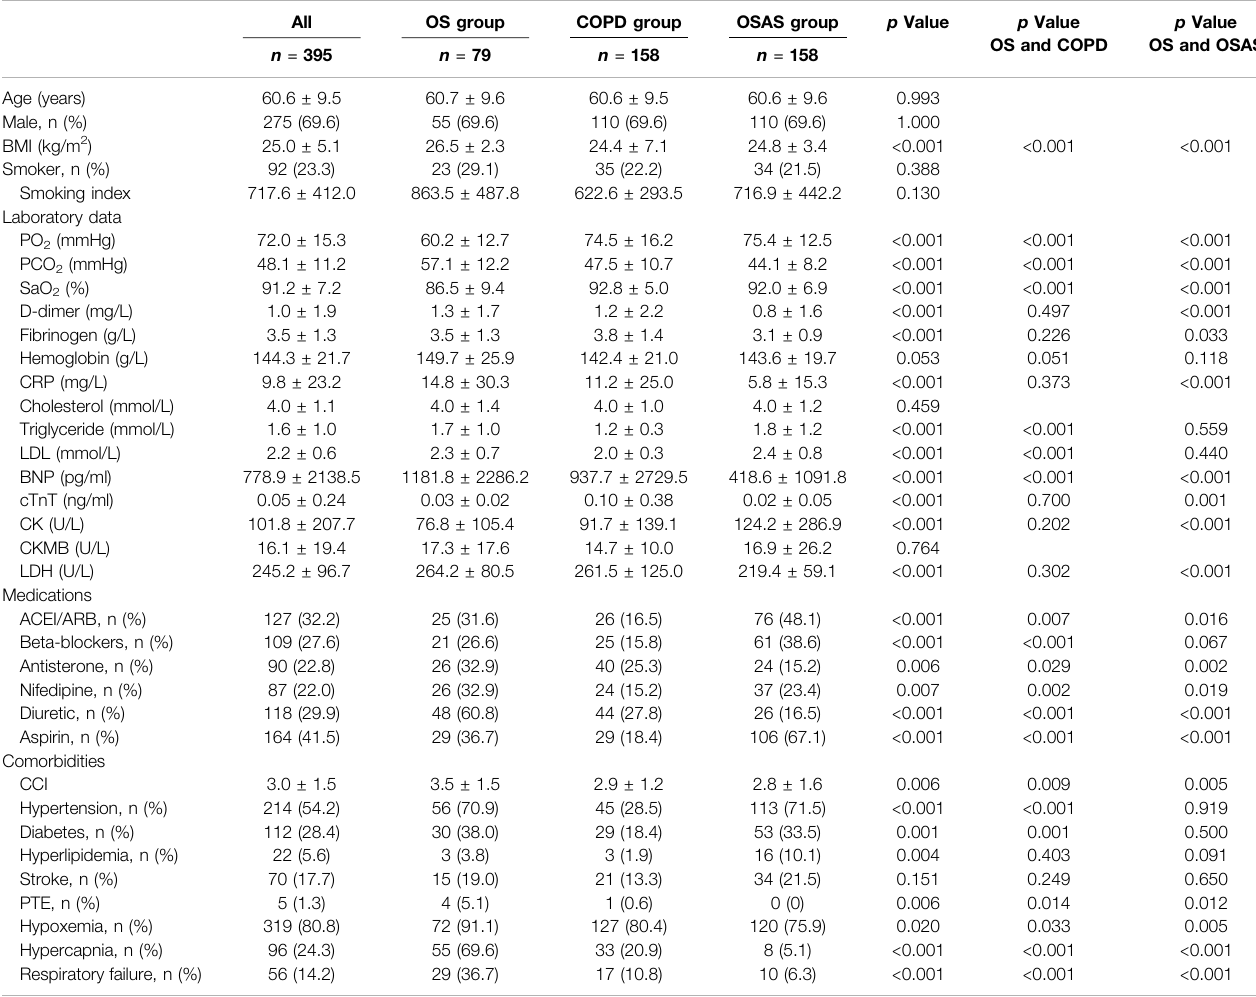
TABLE 1 | Baseline characteristics of all patients. All OS group COPD group